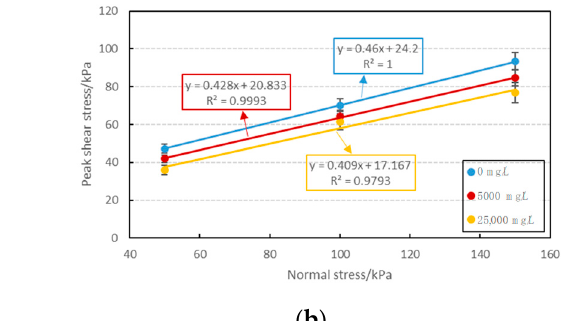
with various sulfate concentrations. ( a ) CPB made with 0% fibers; ( b ) CPB made with 0.3% fibers.